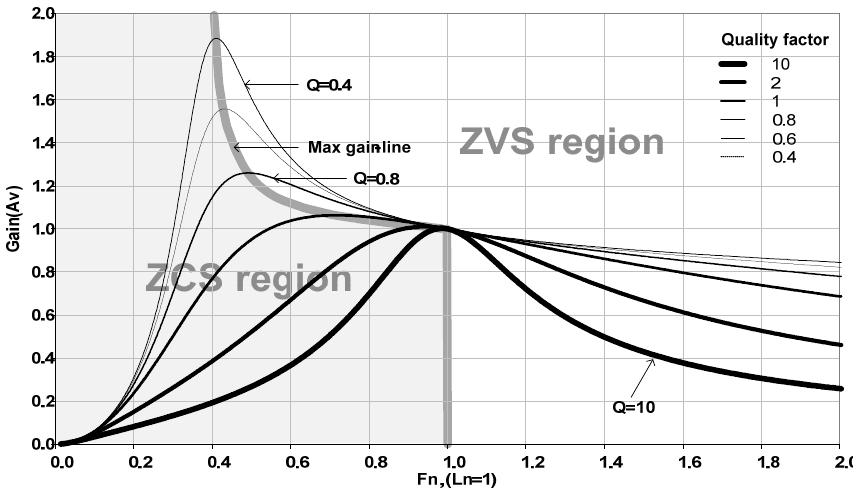
Figure 15. Gain characteristics of LLC resonant converter.